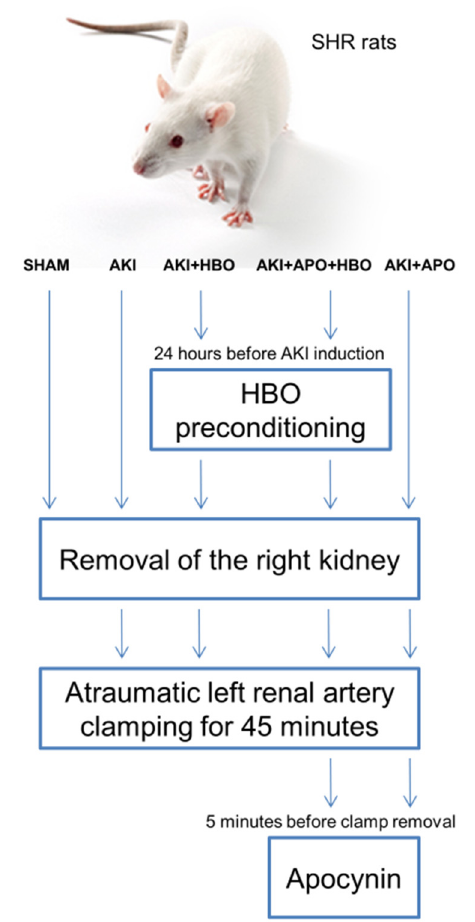
Figure 1. Scheme of the experimental setting. HBO—hyperbaric oxygenation, SHAM—sham- operated rats; AKI—rats with induced postischemic acute kidney injury; AKI + APO—animals with acute kidney injury and apocynin treatment; AKI + HBO—group exposed to HBO preconditioning before acute kidney injury induction; AKI + APO + HBO—animals exposed to HBO preconditioning before and treated with apocynin after acute kidney injury induction.